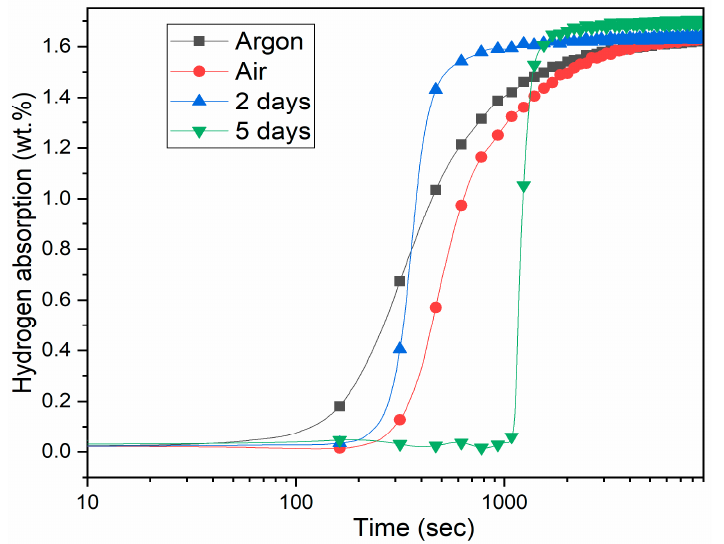
Figure 6. Activation curves at room temperature under 20 bars of hydrogen of as-cast Ti 0.3 V 0.3 Mn 0.2 Fe 0.1 Ni 0.1 alloy crushed in argon and air. The sample crushed in air was further exposed for two and five days.